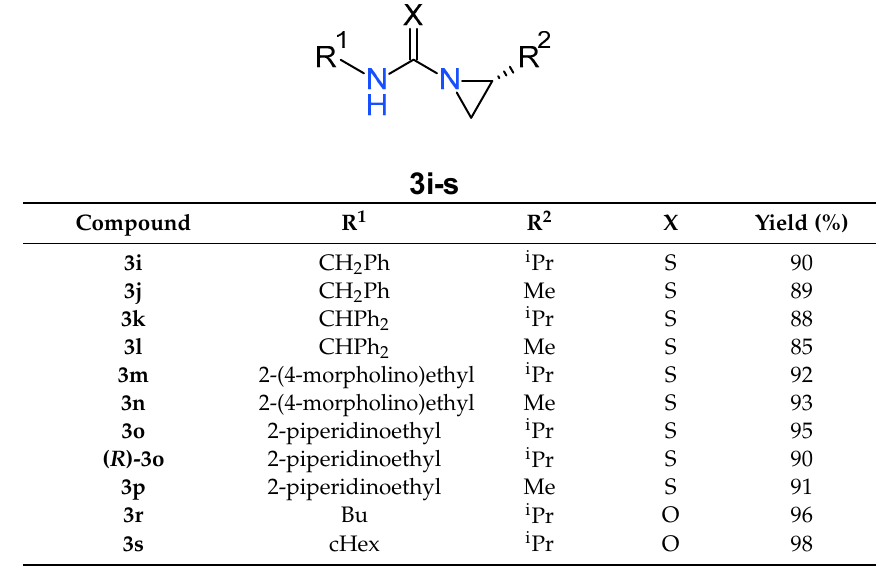
Table 2. Yields of the urea and thiourea derivatives 3i – 3s .